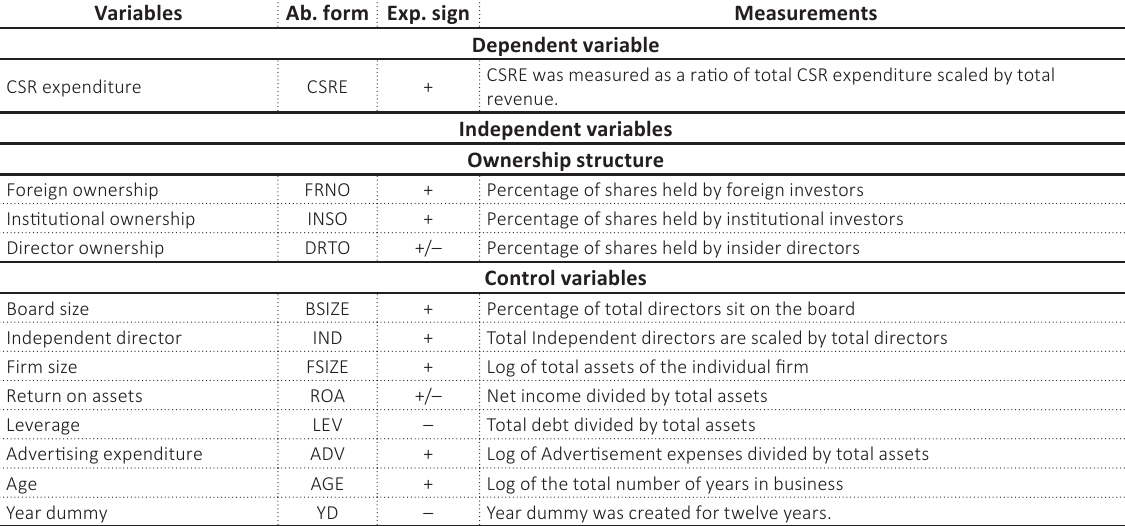
Table 2. Variable definitions and